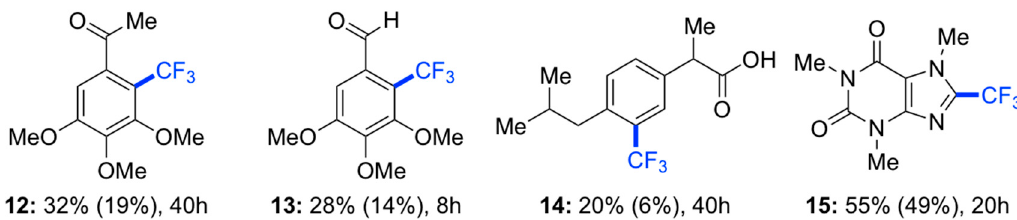
Figure 2. Substrate scope and relative comparison between solution and gel as reaction medium.